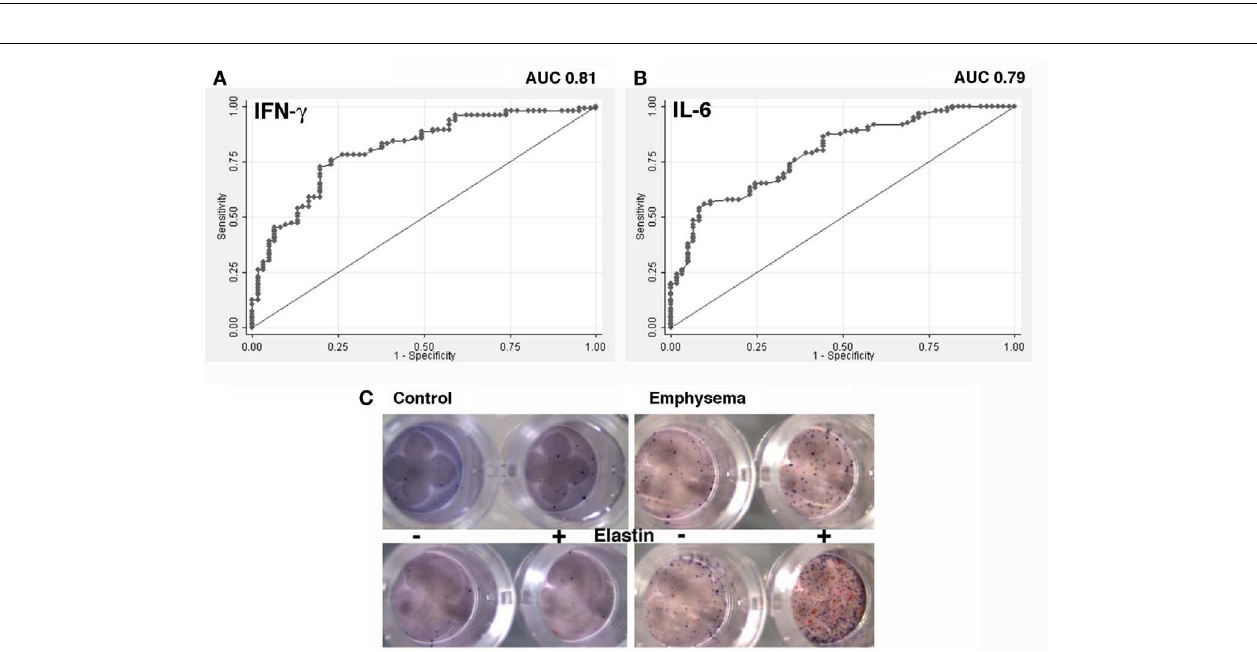
FIGURE 2 | Peripheral bloodT cell response to elastin fragments correlates with disease severity. The low attenuation area (% emphysema) are plotted against the fold increase in production of (A) IFN- γ , (B) IL-6, and (C) IL-17 by freshly isolated peripheral blood CD4 + T